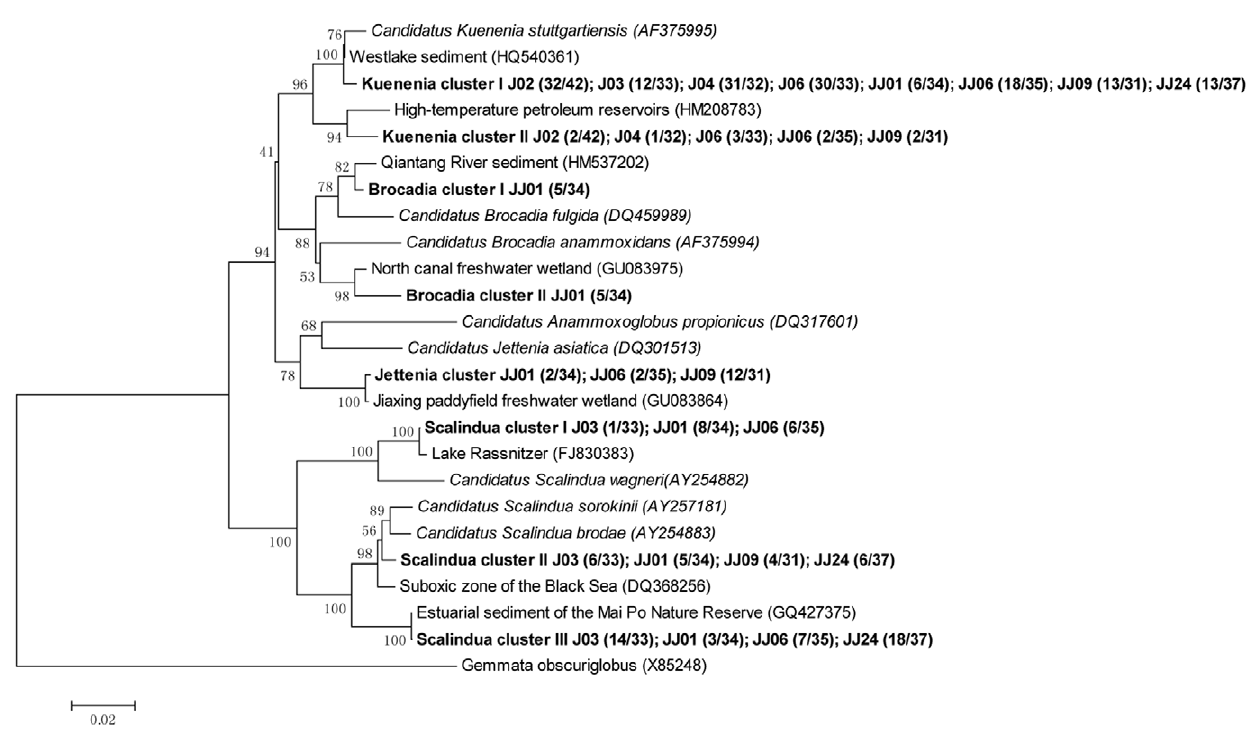
Figure 2. Phylogenetic tree showing the relationships between anammox bacteria-related 16S rRNA gene fragments in the clone libraries of samples from the Jiaojiang Estuary (bold) and known anammox bacteria (italics). Clone names are composed as follows: the sample name followed by the number of times a sequence was detected among all of the tested clones of a sample.